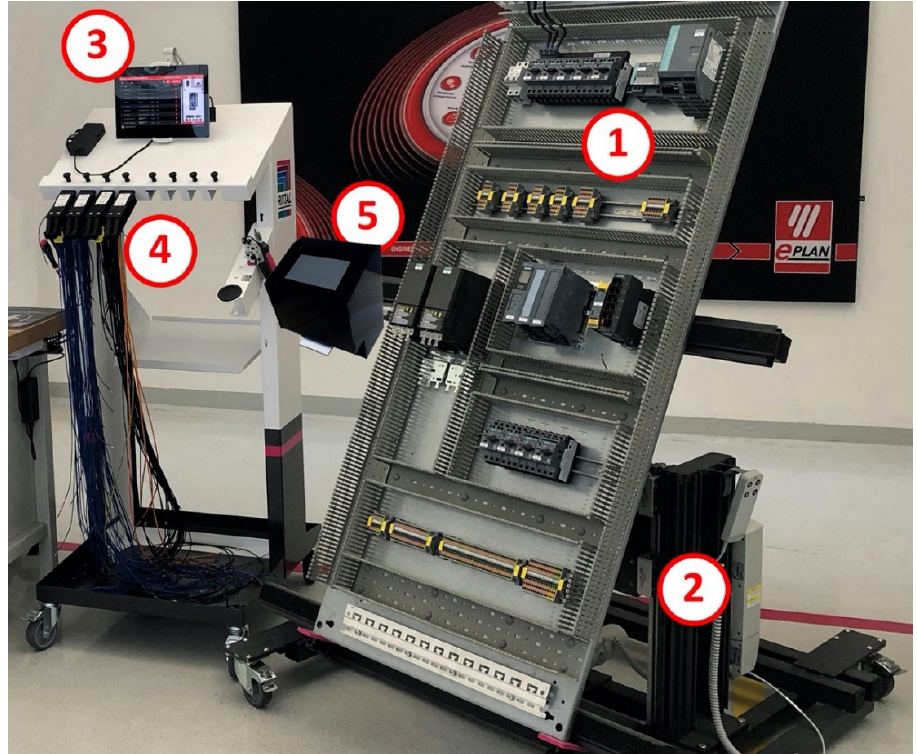
Figure 5. The wiring production station: (1) industrial enclosure and components already in place with certain number of wires assembled; (2) an assembly frame; (3) wiring assembly support software system (EPLAN Smart Wiring); (4) wire holder with preproduced wires; (5) the WLR device.